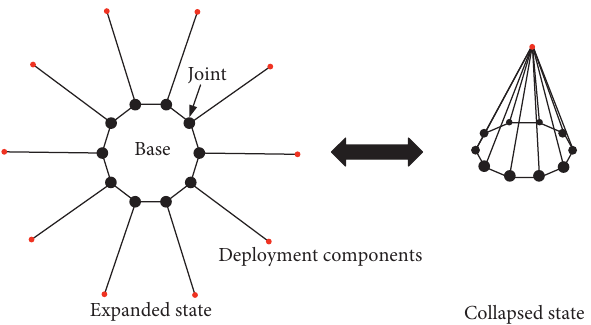
Figure 1: Motion diagram of the space deployment mechanisms.